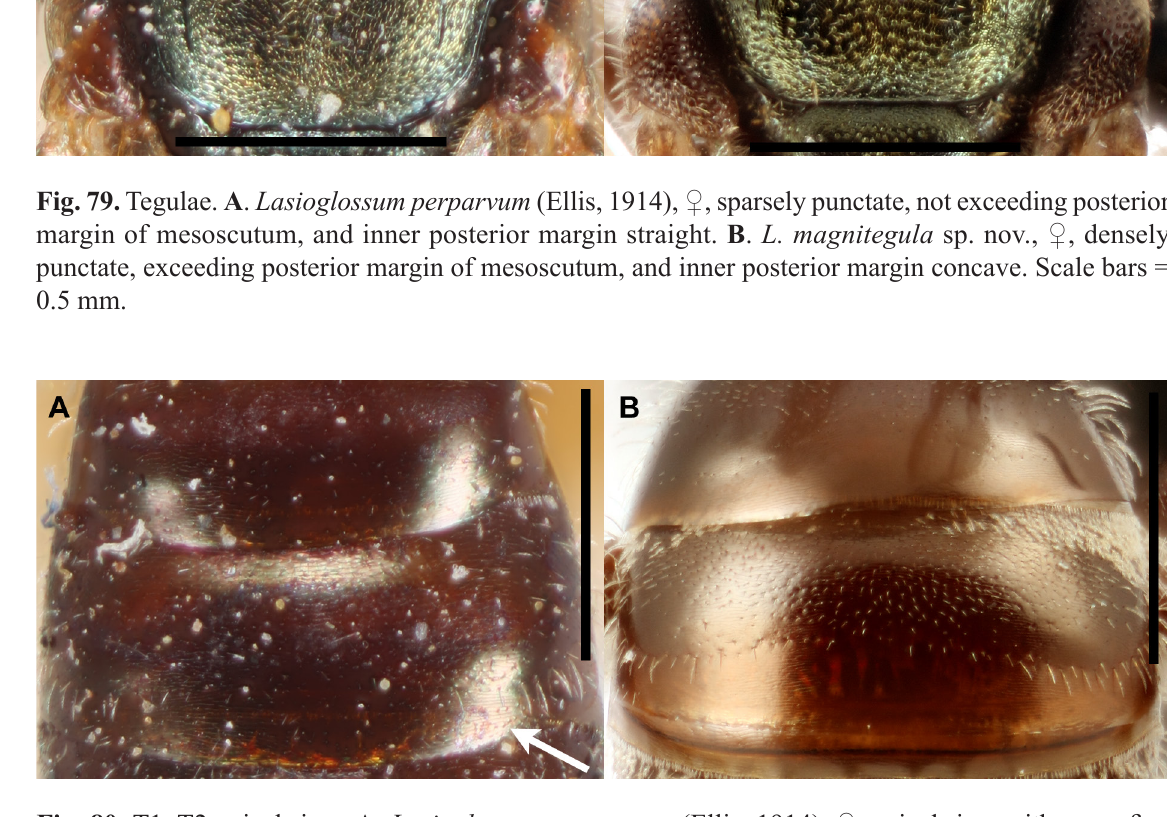
Fig. 80. T1–T2 apical rims. A . Lasioglossum perparvum (Ellis, 1914), ♀, apical rims with some fine punctures and short setae (arrow). B . L. magnitegula sp. nov., ♀, apical rims impunctate and glabrous. Scale bars = 0.5 mm.